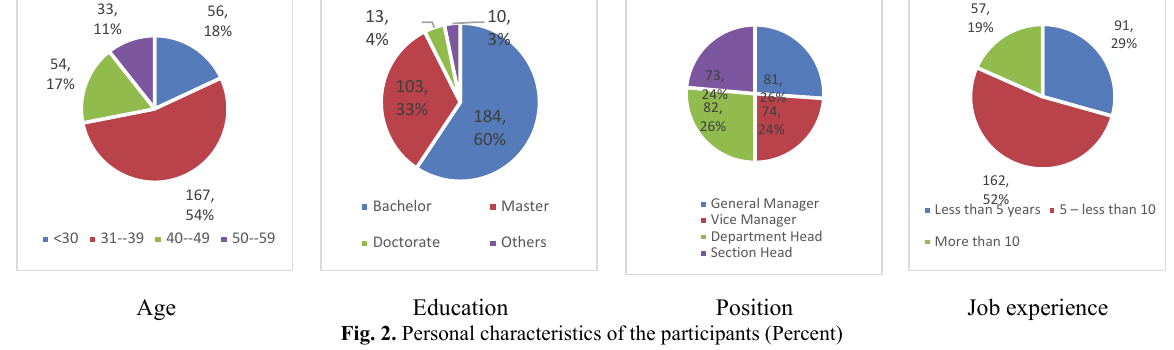
Fig. 2. Personal characteristics of the participants (Percent)